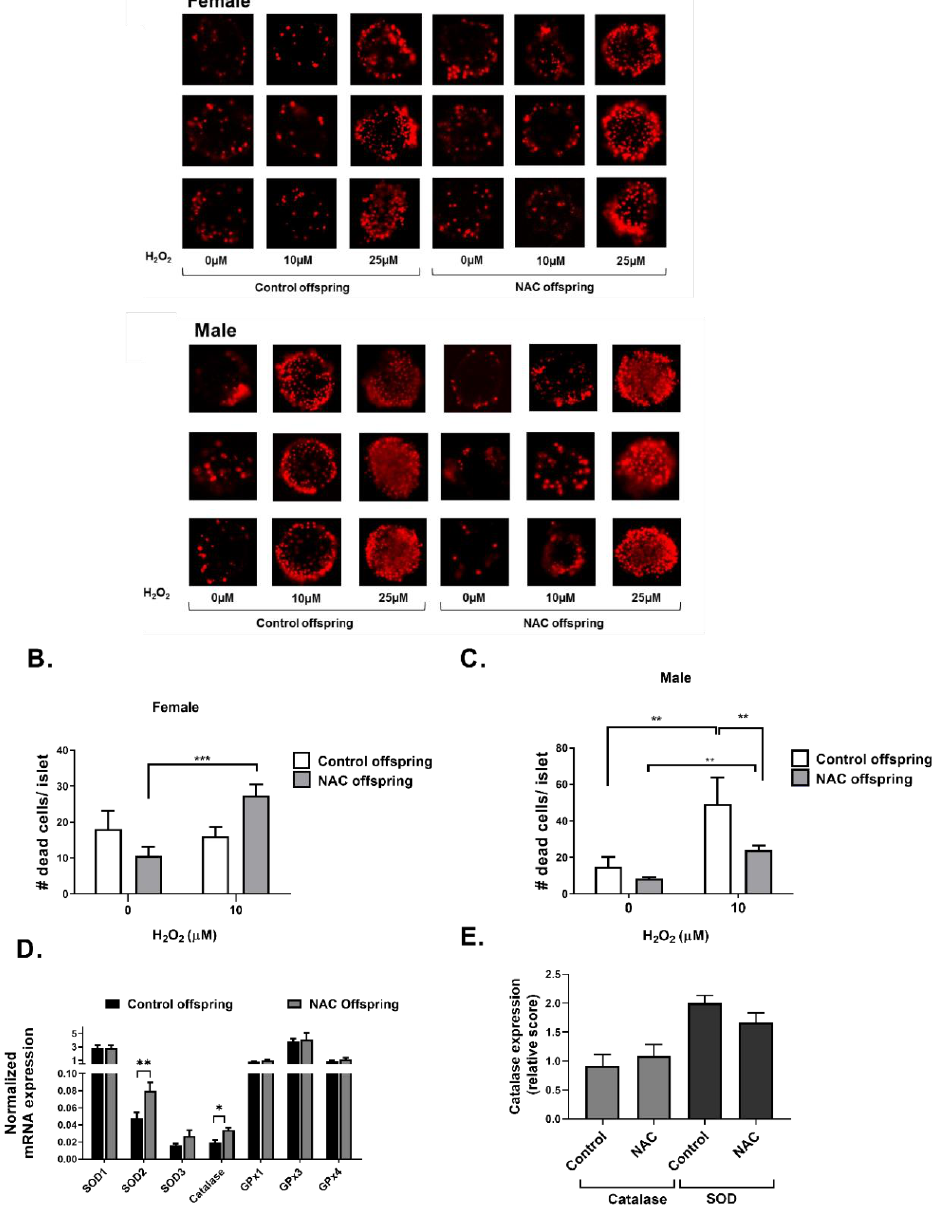
Figure 7. NAC increased the resistance of pancreatic islets against H 2 O 2 -induced oxidative stress. NAC was given to females during pregnancy and lactation. Pancreatic islets of o ff spring were isolated at age of 6 weeks. ( A ) Isolated pancreatic islets were treated with di ff erent doses of H 2 O 2 , and stained with propidium iodide, as described in Methods. A total of 3 representing micrographs are presented. The number of dead cells / islets was quantified in female ( B ) and male ( C ) mice. ( D ) mRNA was isolated from islets of 6 weeks old mice, and expression of selected genes was measured by RTPCR as described in Methods. Results were normalized to the expression of the housekeeping gene, RPS29 and are presented as the mean ± SEM. ( E ) Immunohistochemistry for the expression of SOD and Catalase was performed in pancreas of 6 weeks old male mice, and the expression level was blindly scored. The results are presented as mean ± SEM ( n = 5, 3 replicates for each experiment), * p < 0.05, ** p < 0.005 and *** p < 0.0005 in one-way Anova followed by Tukey’s